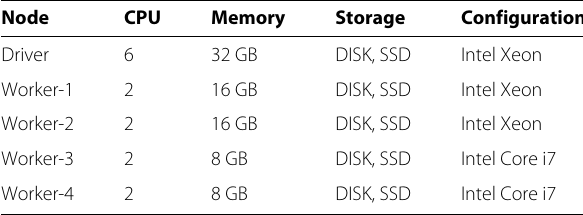
Table 3 Virtual machines over spark